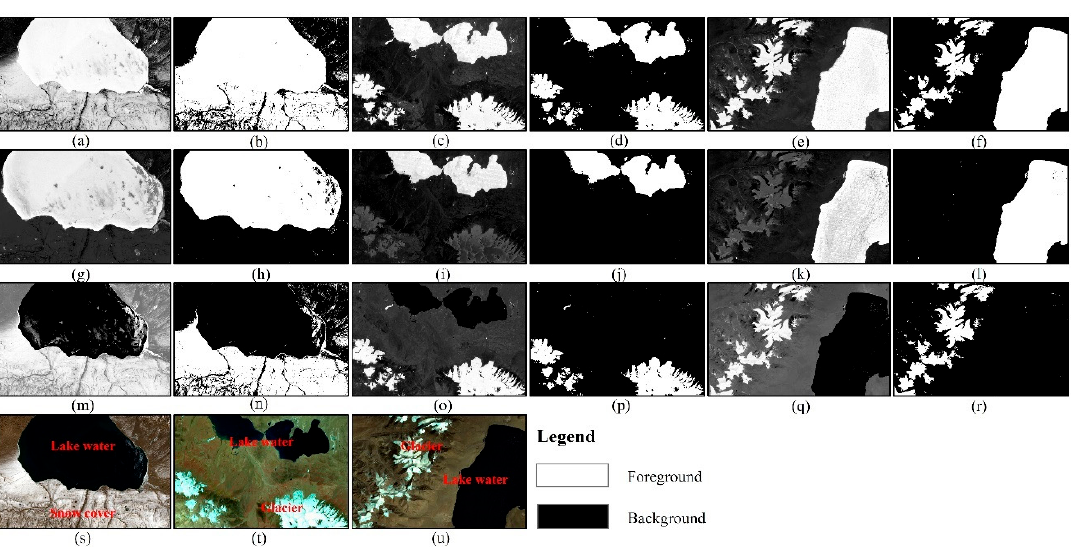
and III; ( b , d , f ) are classified NDSI / MNDWI image in region I, II and III; ( g , i , k ) are the NDWI ns image region I, II and III; ( b ), ( d ) and ( f ) are classified NDSI/MNDWI image in region I, II and III; ( g ), ( i ) and